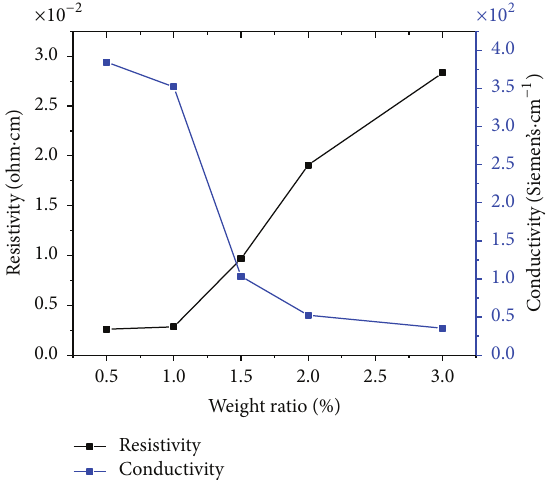
Figure 7: Resistivity and conductivity of TiO 2 thin films with different wt% of carbon